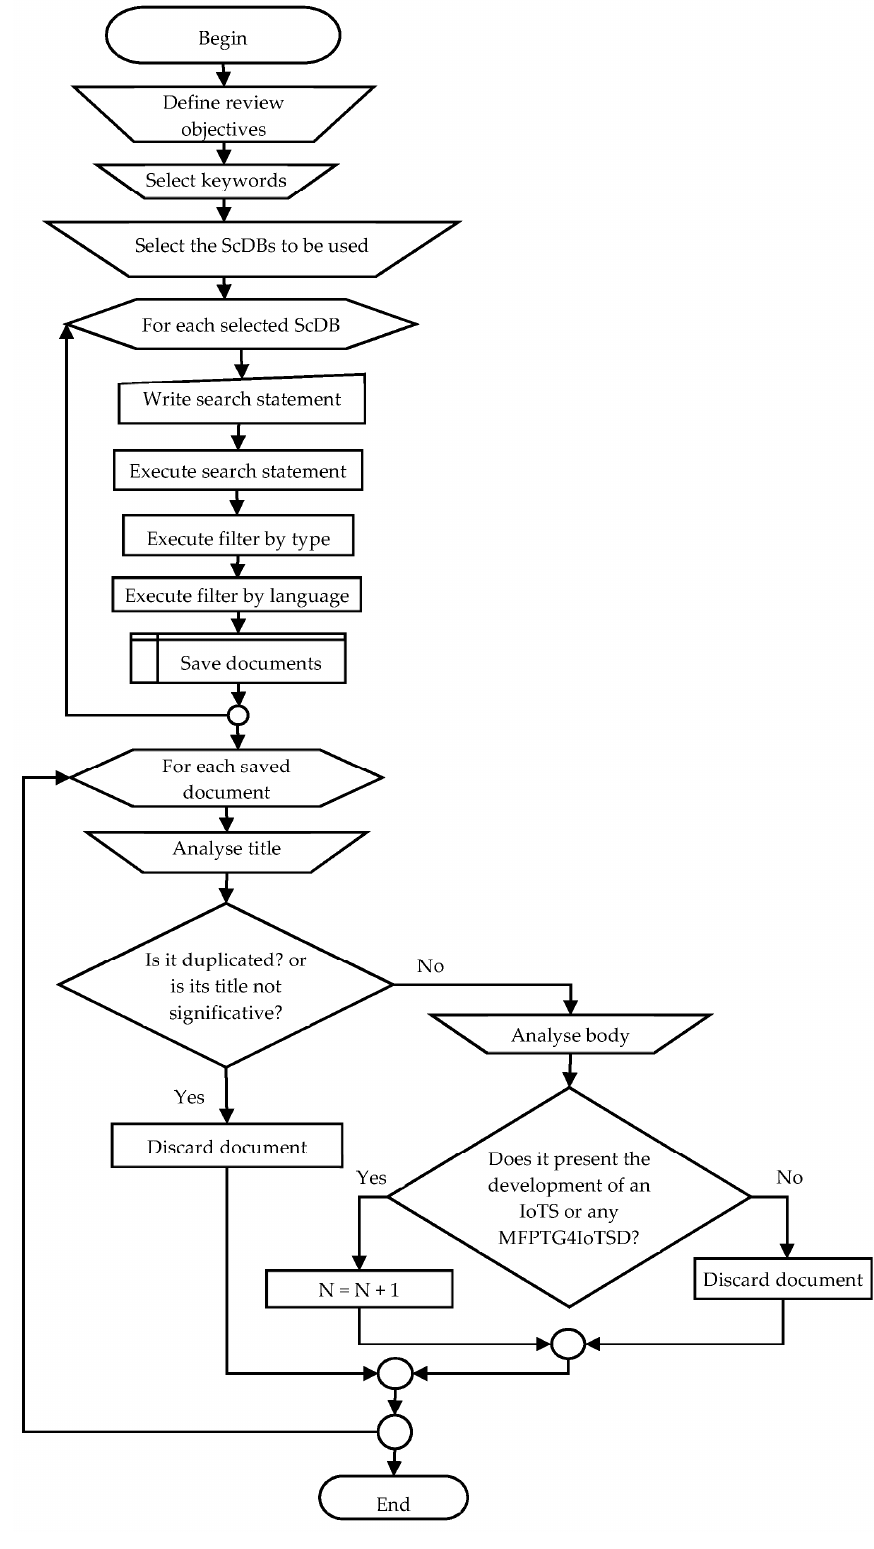
Figure 2. Flowchart of the state-of-the-art review process.